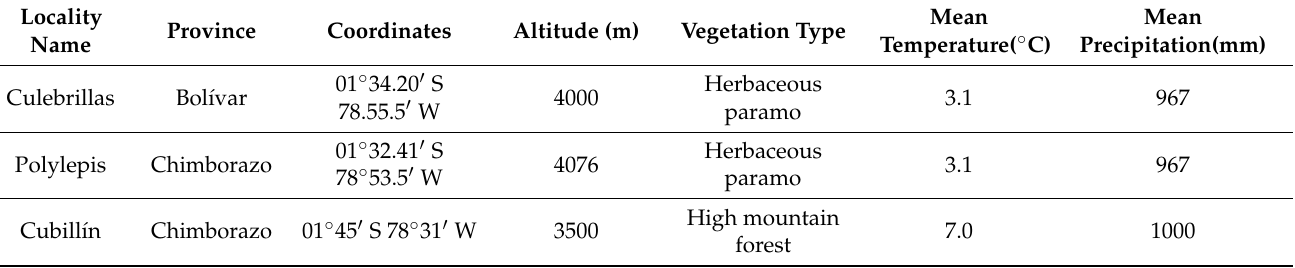
Table 1. Sampling areas where the mortiño berries were harvested in the paramo of the Chimborazo volcano, Ecuador.